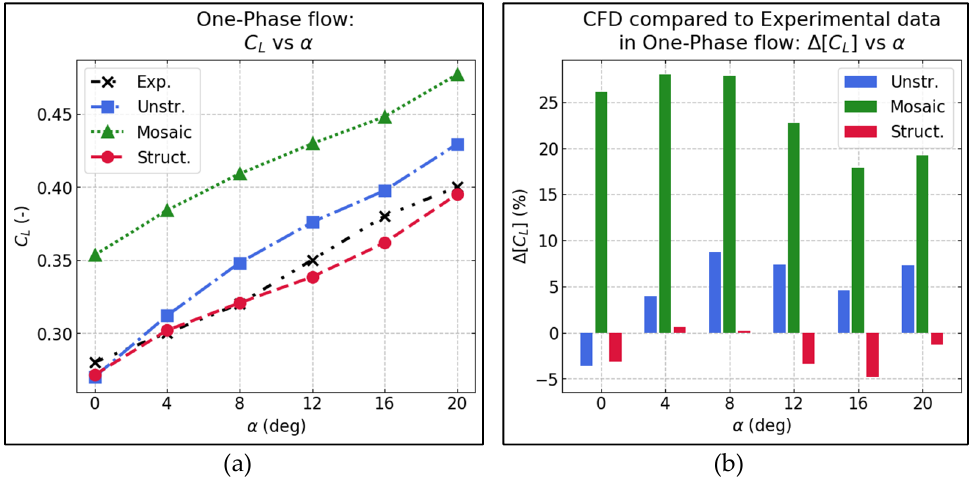
Figure 9. ( a ) Lift coefficient of wing from numerical simulations under 3 different meshes and ex- periment ( b ) Deviation of simulations lift coefficient compared to experimental results.